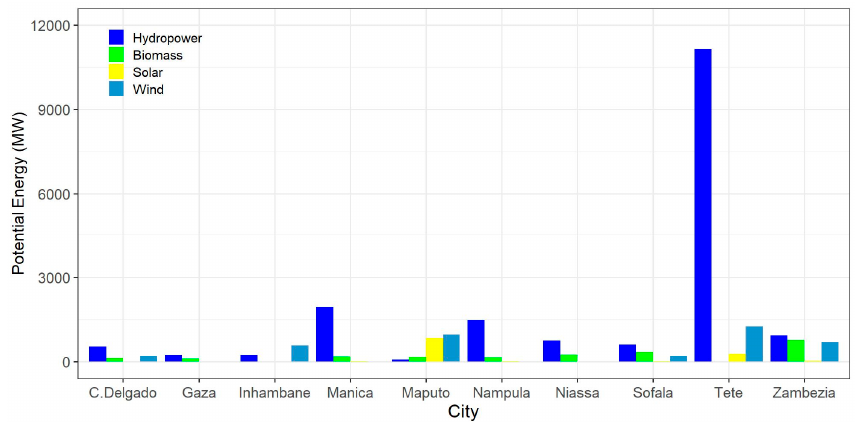
Figure 3. Hydropower potential and other forms of renewable energy in Mozambique. Source: own illustration with information from [7,32].